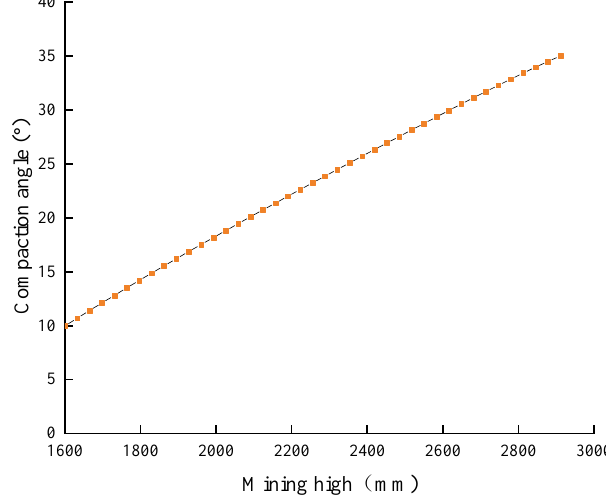
Figure 19. Compaction angle of the ZC4800/16/30 backfilling hydraulic support. The distance from the top refers to the vertical distance between the compaction head at the front end of the compaction mechanism and the top plate after the compaction mechanism of the backfilling hydraulic support is fully extended. In Figure 20, the distance from the top changes in a smiling curve, and the bottom of the smiling curve is the most suitable working height area for the support. It roughly coincides with the mining height range of 2.0–2.5 m, indicating that the distance from the top is more reasonable. The sensitive area of the distance from the top is located on the right side of the most suitable working height area, just avoiding the influence of the change at the mining height of 2.0–2.5 m.